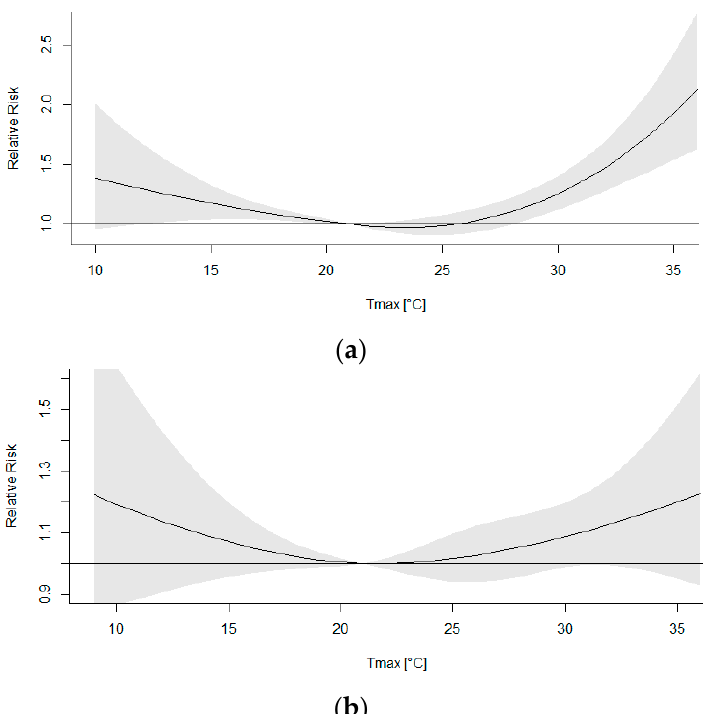
Figure 13. Relation between daily maximum temperature and relative mortality risk (cardiovascular